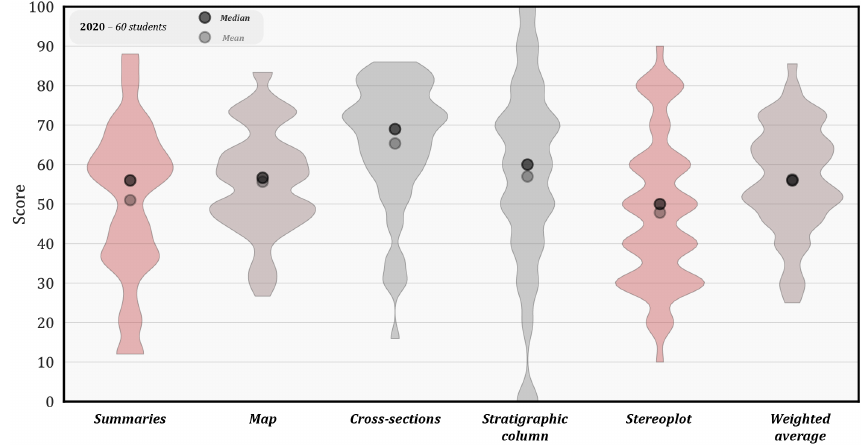
Figure 7. Violin plots (i.e. two-sided histograms) of the students’ grades on the different evaluated tasks. Note the large spread in the grades.